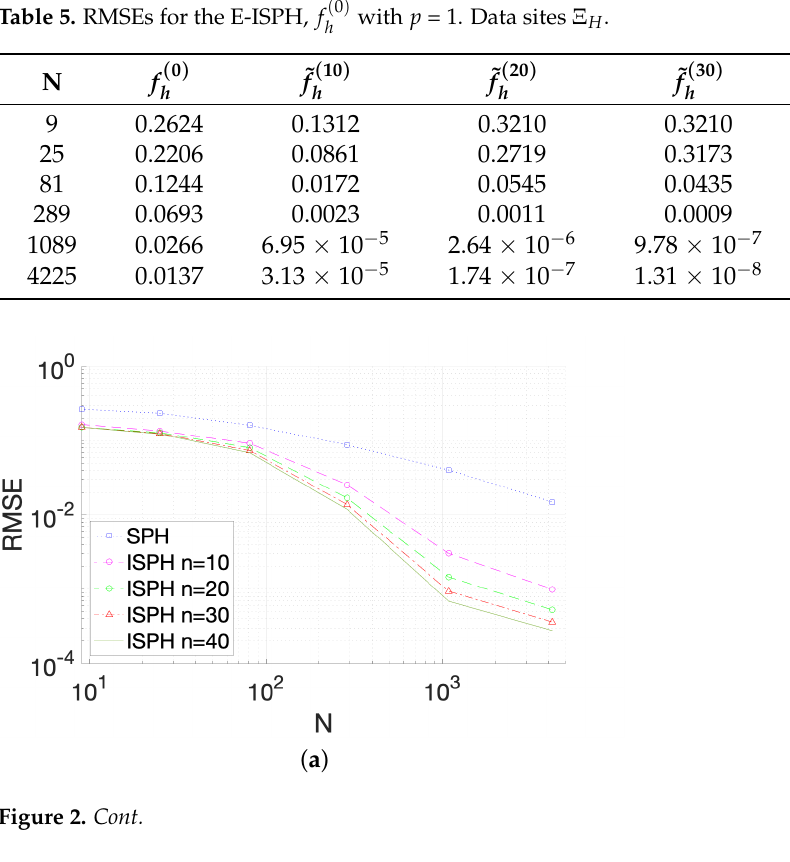
Table 5. RMSEs for the E-ISPH, f